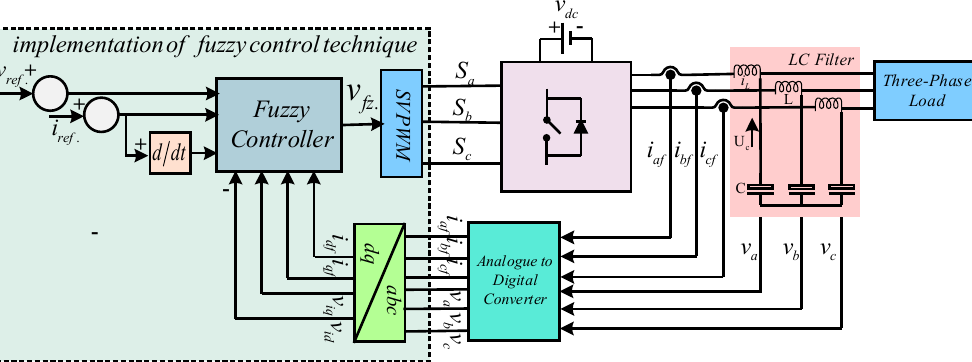
Figure 28. A Fuzzy control algorithm topology on a VSI.